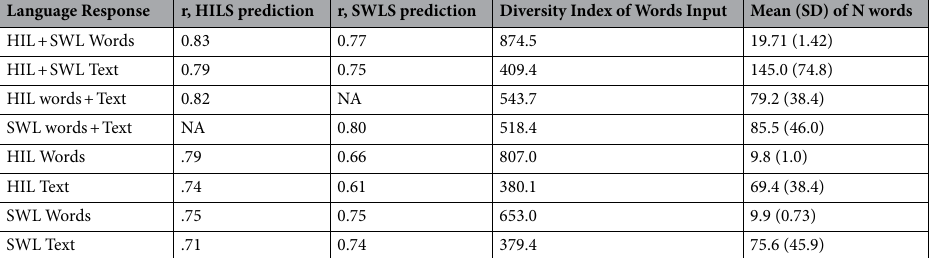
Table 5. Word- versus Text-Responses: Accuracy (r), Diversity Index, and Mean (SD) number of words. All correlations were significant at p < 0.001. N = 608. BERT large using the second last layer (L23). HIL = Harmony in life; SWL = Satisfaction with life; S = Scale. Diversity index of Words Input is 2 entropy , which indicates how many different “types” (i.e. distinct categories) that could theoretically be accounted for by the